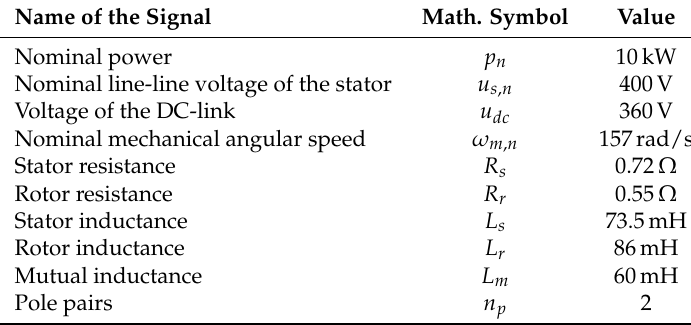
Figure 4. The used test bench to validate the proposed LPS-MRAO. Table 1. Parameters of the utilized